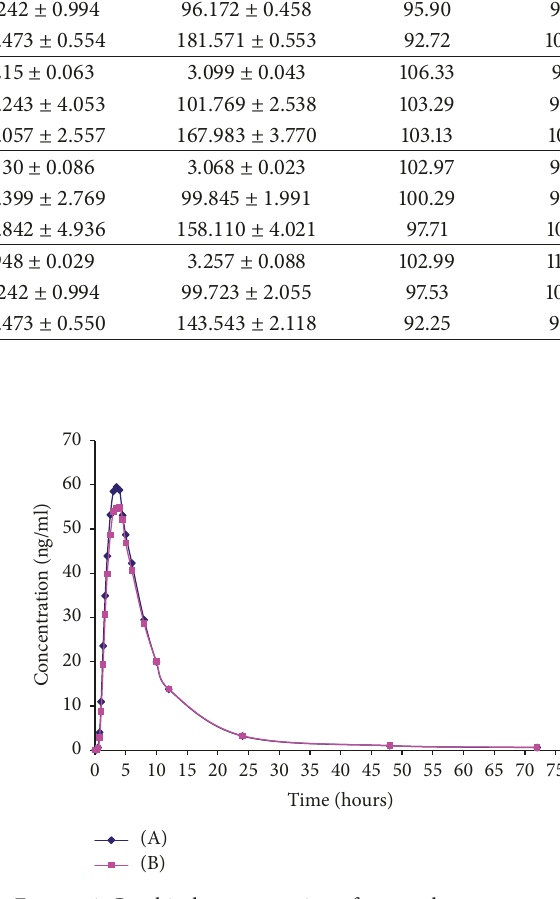
Figure 6: Graphical representation of mean plasma concentration versus time of enalaprilat following 20 mg single oral dose of test (B) and reference preparation (A) to 30 healthy human